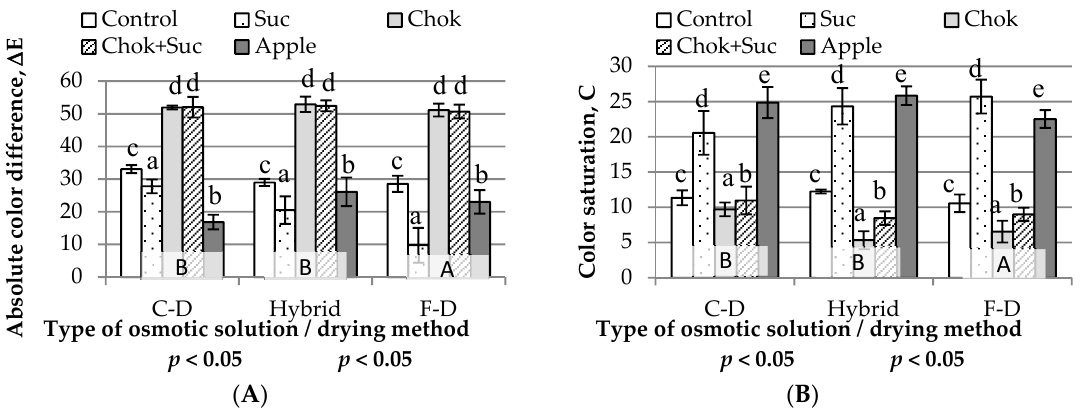
Figure 6. Influence of the type of osmotic solution and drying method on: ( A ) absolute color difference and ( B ) color saturation of quince chips. Designations: a–d, A, B—homogeneous groups; Suc, Chok, Chok + Suc, apple—coding the type of osmotic solution and C-D, hybrid, F-D—coding the type of drying method as given in the Experimental procedures.